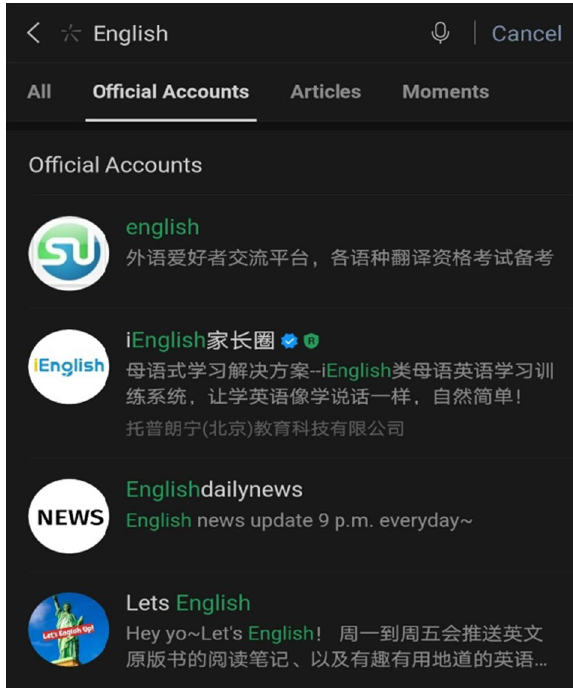
Fig. 9 Results from searching for